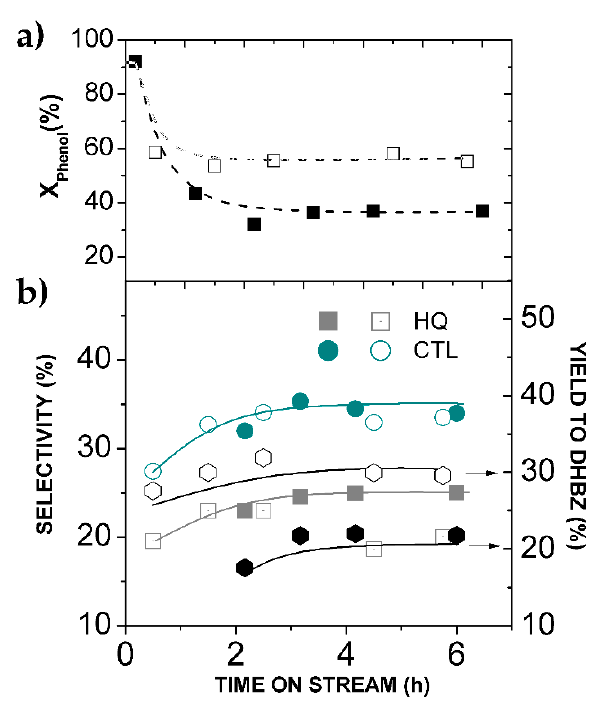
Figure 6. Results of the hydroxylation of phenol over Fe-BDT in a flow-reactor. ( a ) Evolution of phenol conversion and ( b ) evolution of phenol selectivity to hydroquinone (HQ) and catechol (CTL) and DHBZ yield with time on stream. Operating conditions: [Phenol] 0 = 0.35 mol L − 1 , T = 25 ◦ C, W FeBTC = 0.025 g, Q L = 0.25 mL min − 1 , τ = 1.7 g h L − 1. Open and close symbols: phenol:H 2 O 2 = 1:1 and 1:0.5,